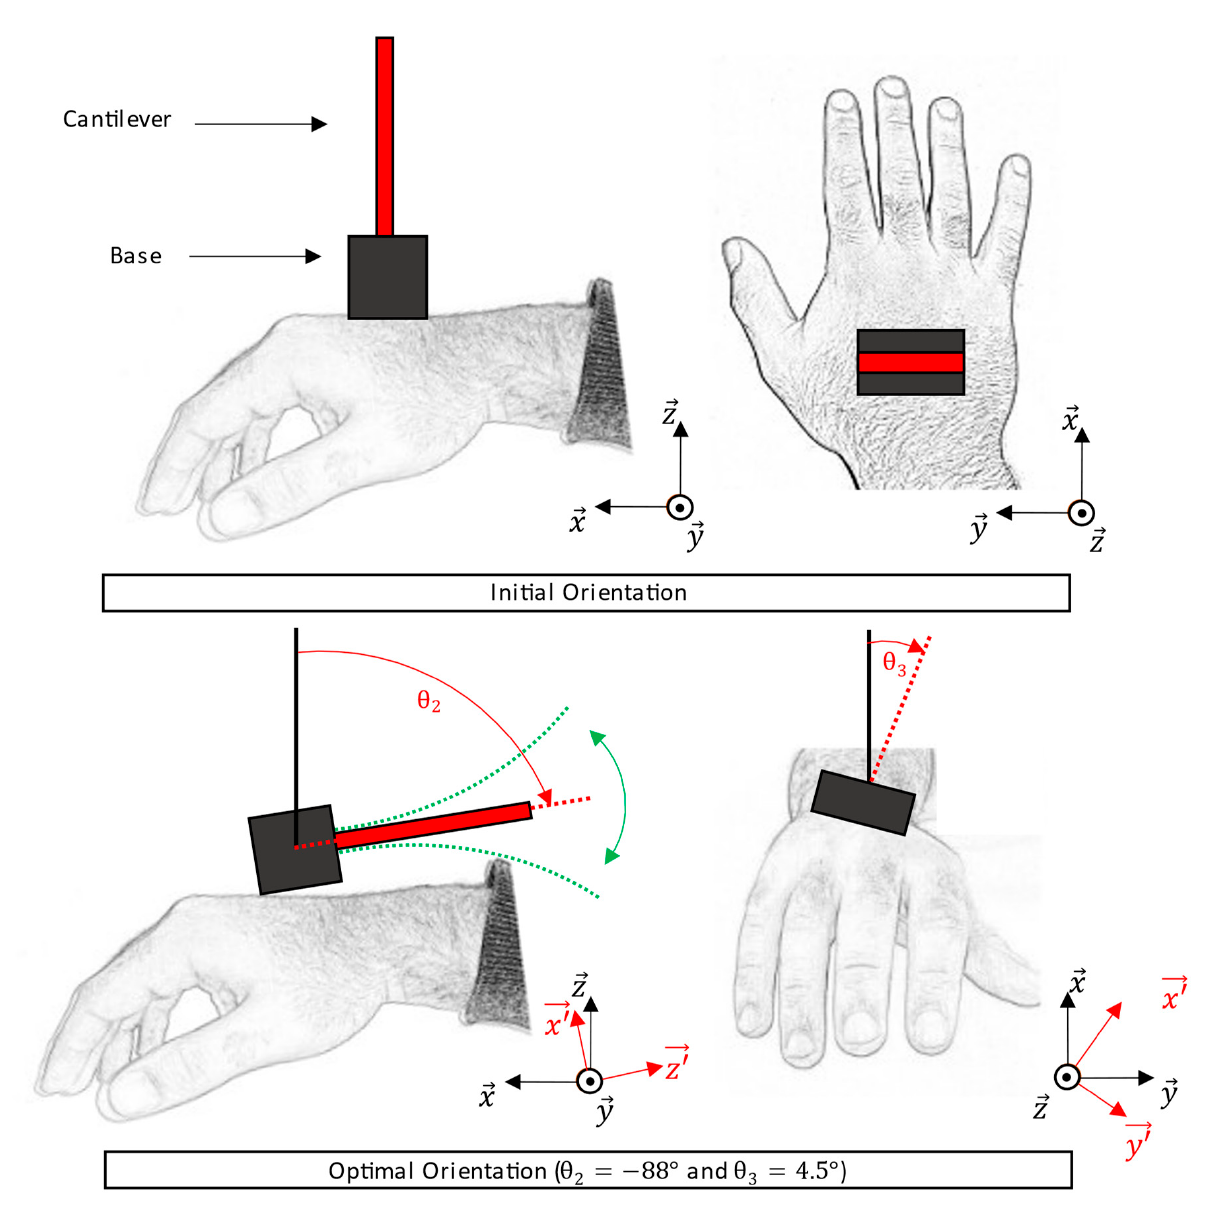
Figure 9. Initial and optimal orientations of the harvester on the right hand. On the top, the initial fictive placement of the harvester is presented. This position corresponds to the IMU orientation with the DA aligned with 𝑥⃗ . On the bottom, the optimal orientation, according to Figure 8, is presented, with rotation around 𝑦⃗ 𝑎𝑛𝑑 𝑧⃗.